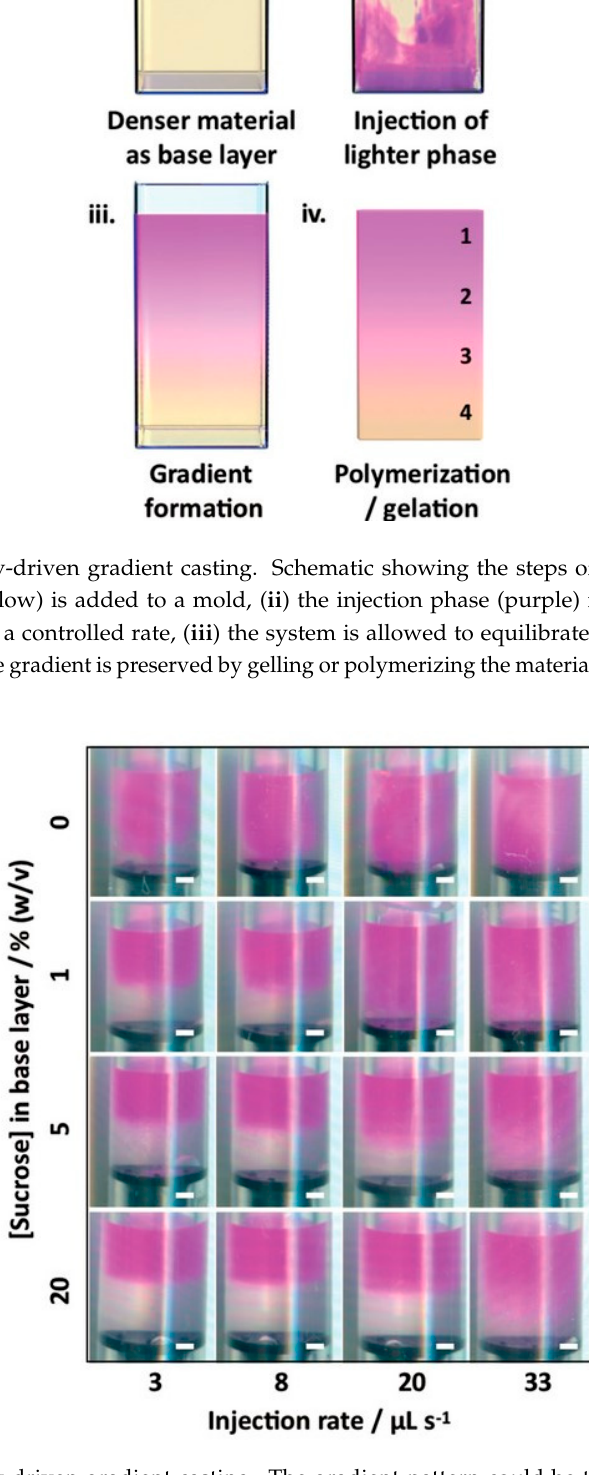
Figure 8. Buoyancy-driven gradient casting. The gradient pattern could be tuned by varying the injection rate and concentration of sucrose in the base layer. Reprinted from [24] with permission.